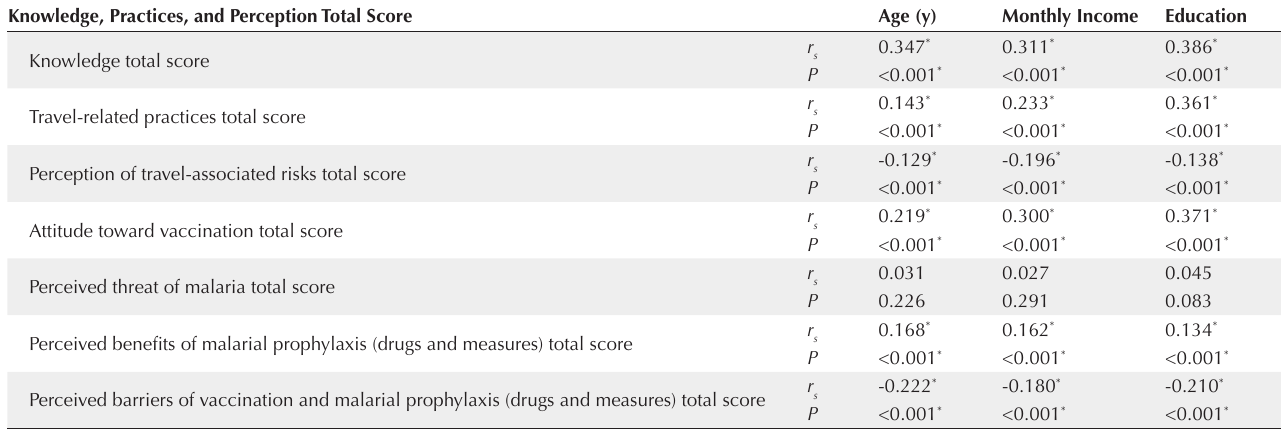
Table 7. Correlation Between Age, Income, and Education Level With Total Score of Knowledge, Attitude, and Practices Knowledge, Practices, and Perception Total Score